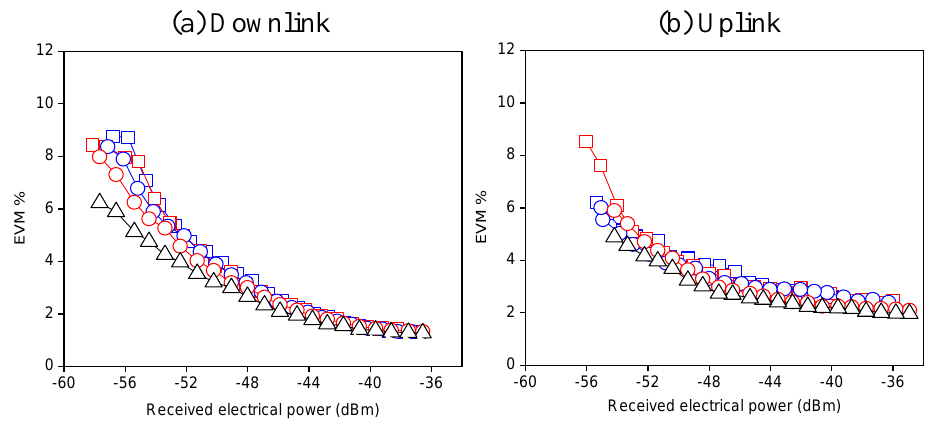
Figure 5. EVM vs. received electrical power for extra capacity wavelengths. λ1 E [Scenario 1 (  ) and 2(  )]. λ2 E [Scenario 1(  ) and 2(  )].Optical back-to-back (  ). ( a ) Downlink and ( b ) uplink